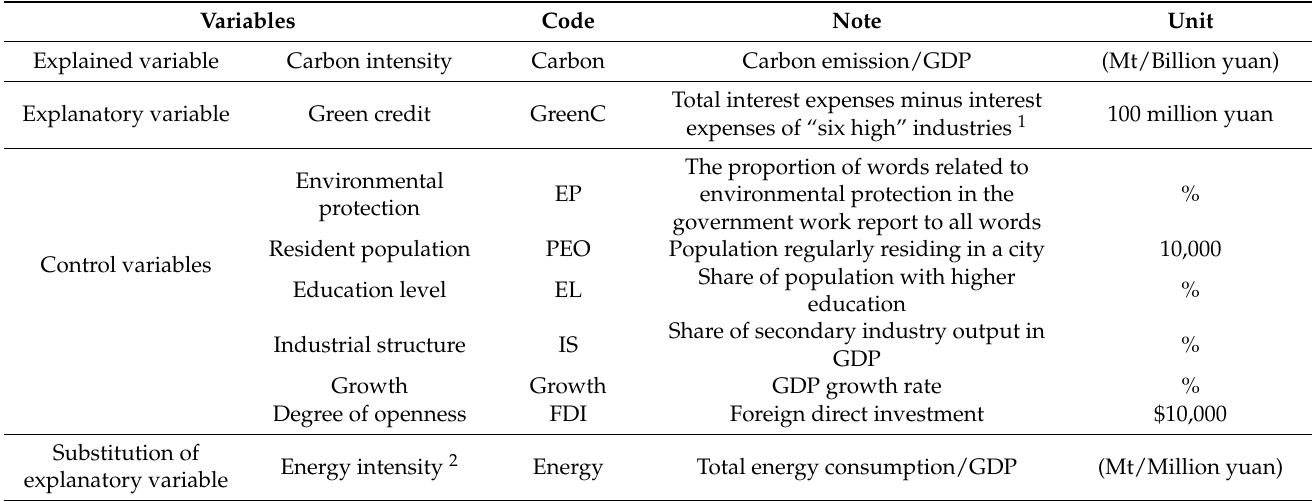
Table 3. Explanations for variables in